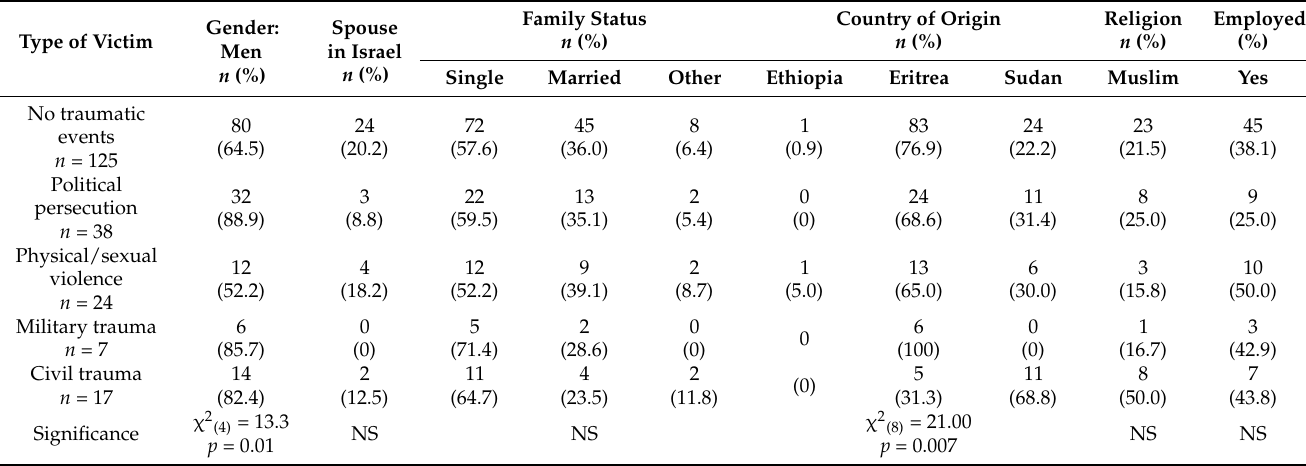
Table 1. Demographic variables across different types of traumatic events in country of origin.